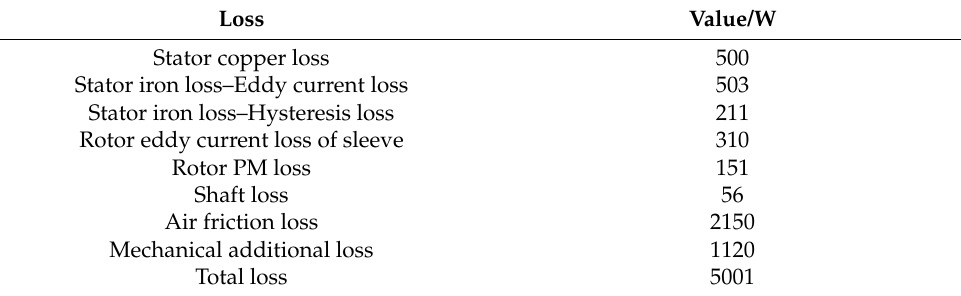
Table 5. Various loss values of high ‐ speed motor by FE.